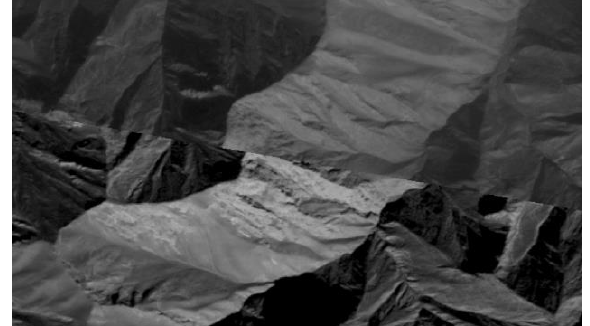
Figure 12. The accuracy of plane edge connection exceeds the